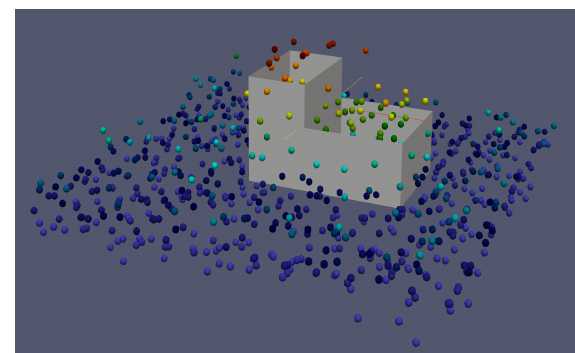
Figure 5: Reconstruction result obtained after 10 iterations with SNR = 20dB. The color encodes the height of the scatterers. The walls are visualized by surfaces although this might hide some scatterers which are located slightly behind the wall. The scene was illuminated from all four directions such that a wall is only visible in one aspect. Note that the resolution of 5m × 5m is quite low. Note also that the points on the facades belong to just one aspect. This implies that here the point density is four times lower than in areas visible in all